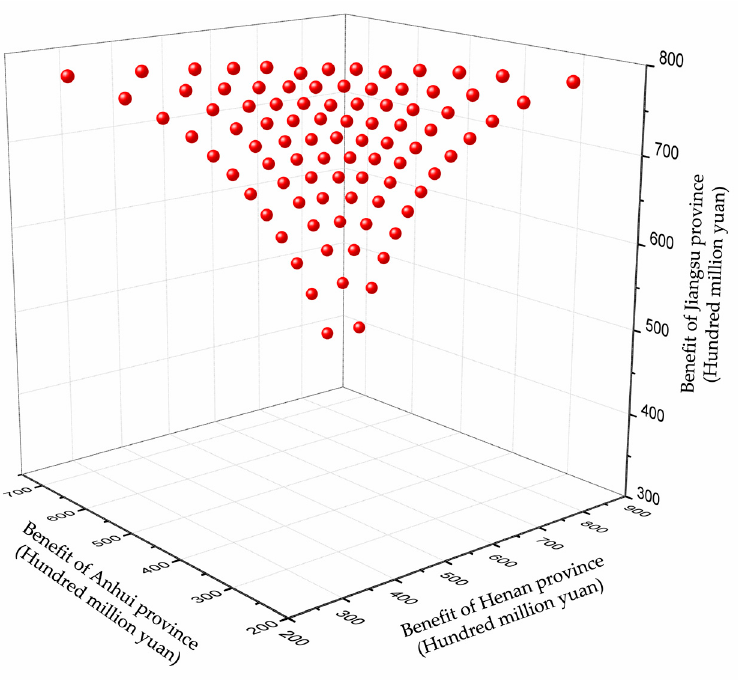
Figure 5. Pareto front of multi-objective optimization based on the AR-MOEA method in the Huaihe River basin.